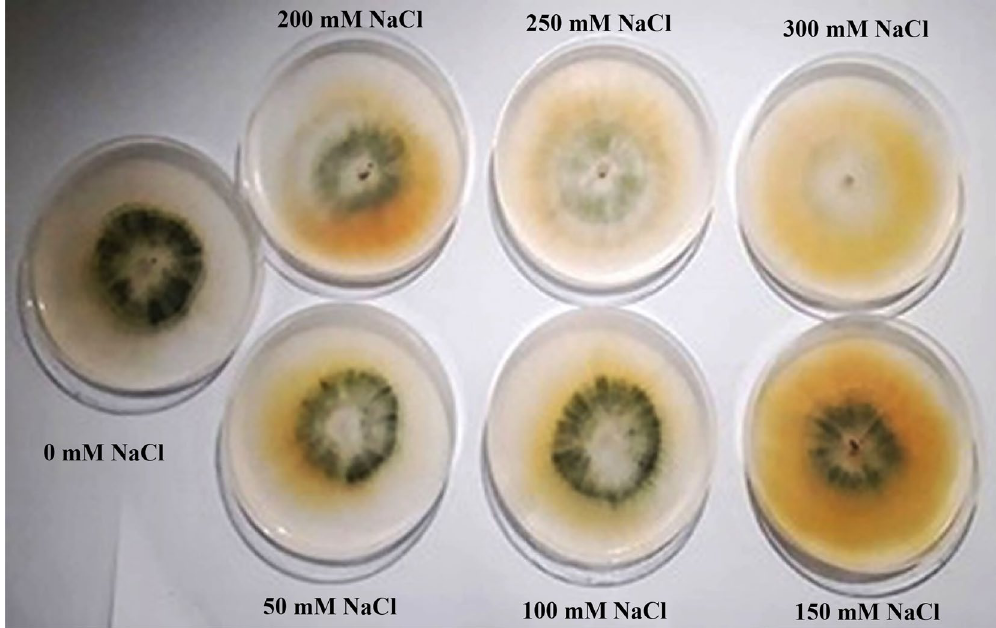
Fig. 1 Illustrative photograph showing the effect of NaCl concentrations on T. viride growth colonies grown at 25 °C and photographed after 2 days. To determine the effects of NaCl on T. viride , mycelia discs (6 mm) of active culture were used to inoculate PDA medium with or without NaCl